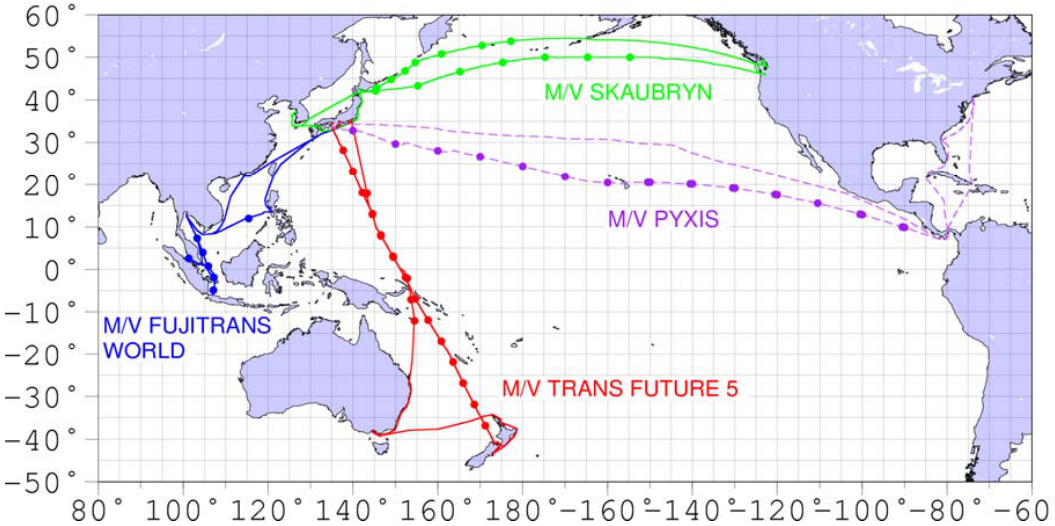
Figure 1. Current geographical coverage of atmospheric monitoring in the NIES VOS program: Southeast Asia route by Fujitrans World (blue); North America route by Pyxis (purple) and Skaubryn (green); Oceania route by Trans Future 5 (red). For atmospheric CO, both continuous measurement and flask sampling followed by GC/RGD analysis are being conducted along the three routes indicated by solid lines, whereas only flask sampling is conducted along the route indicated by the dashed lines. Dots denote flask sampling points.